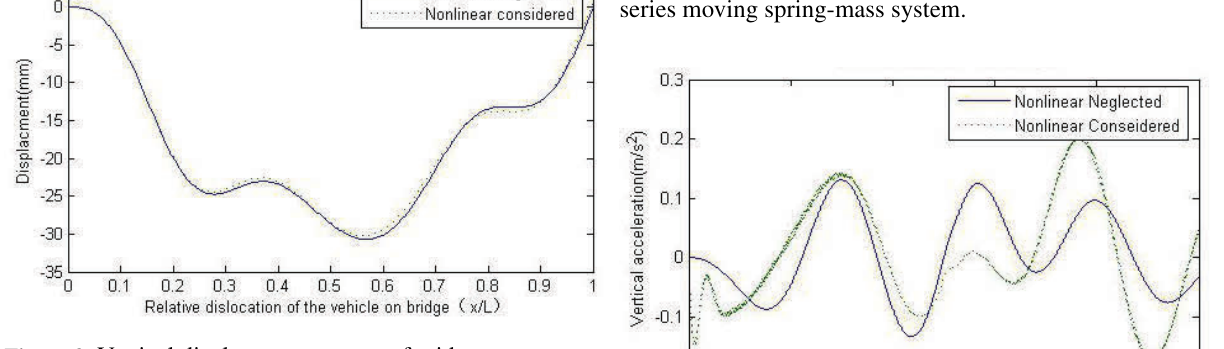
Figure 3. Vertical displacement curves of mid-span.